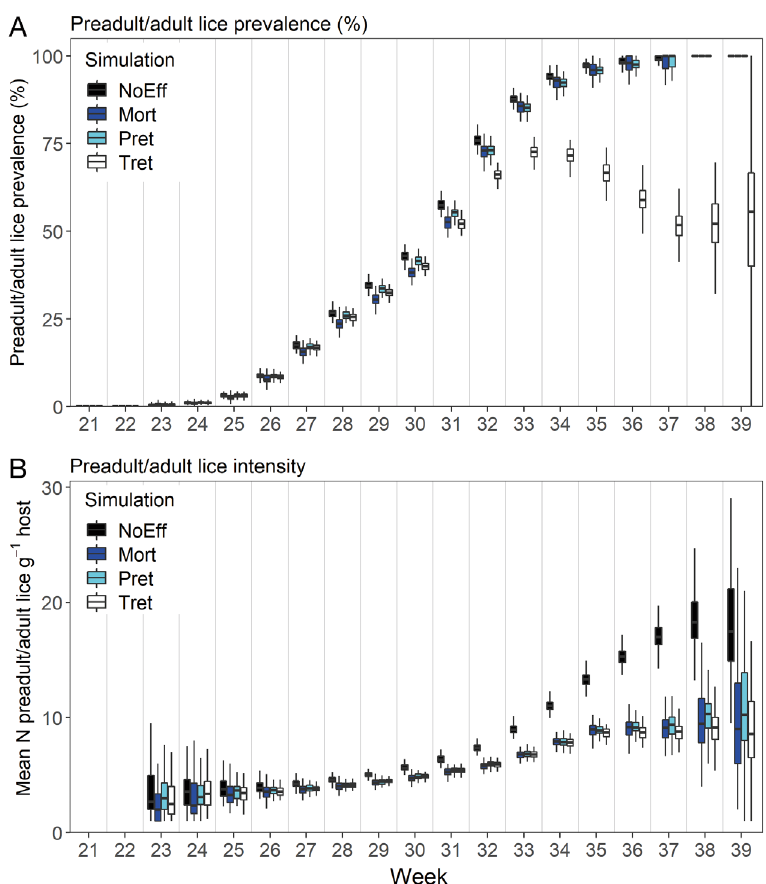
Fig. 4. Intra-annual pattern of (A) preadult/adult lice prevalence and (B) preadult/adult lice intensity (mean N preadult/adult lice g −1 host) of sea trout resident at sea for simulations with lice effects absent (NoEff), lice-induced mortality (Mort), lice-induced persistent premature return (Pret) and lice- induced transitory premature return (Tret). Individuals within freshwater (which all have zero lice) are excluded. Here and in Figs. 5 & 6, boxplots are created from annual values for the given week. Here and in Figs 5–9, boxplots are centered around the median (horizontal lines), within the 25th and 75th percentiles (boxes), with whiskers extending to the largest value no further than 1.5 × the interquartile